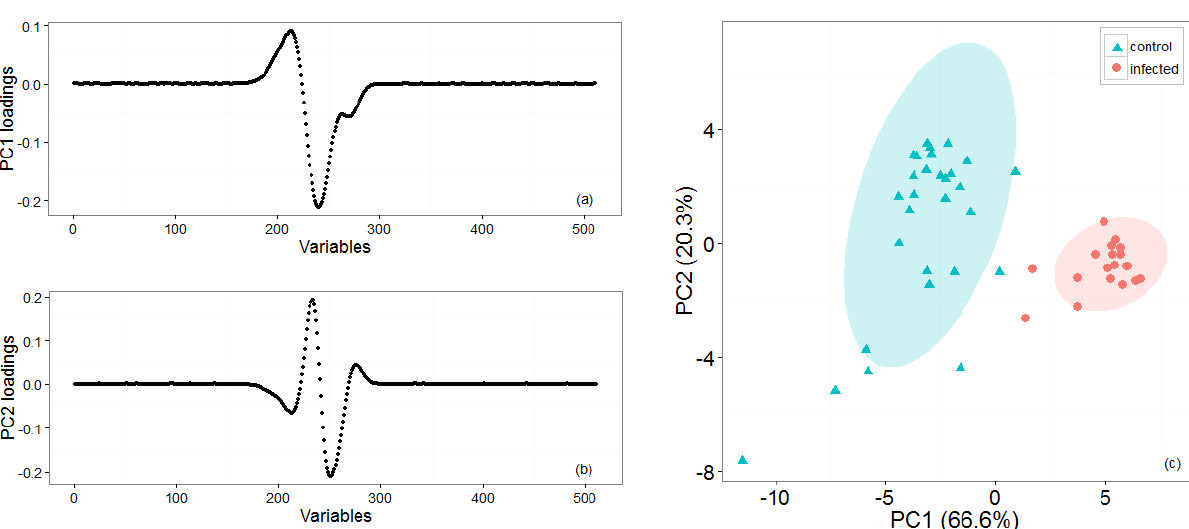
Figure 6. Fourth set of experiments: Loading plots ( a , b ) for the two first principal components that account for most of the variance. ( c ) PCA and k-means clustering for two groups of potato tubers with controls (cyan triangles) and infected (red circles) which have been grouped with 95% confidence ellipses around the centroid identified by the k-means